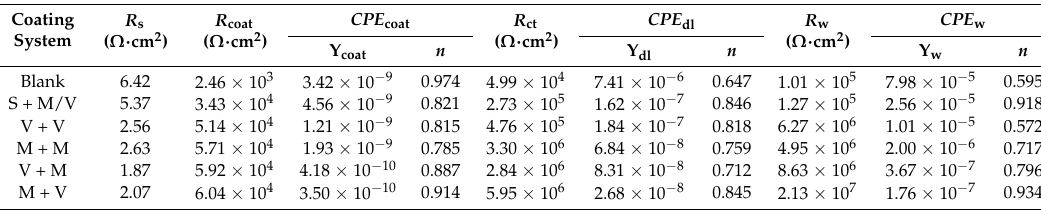
Figure 7. Electrochemical impedance spectroscopy (EIS) spectra and the equivalent electrical circuits of AA2024 coated with different coatings immersed in 3.5 wt.% NaCl solution for ( a – c ) 30 min and ( d – f ) 27 days. Table 2. Resistance and capacitance parameters of different coatings after immersed in 3.5 wt.% NaCl solution for 27